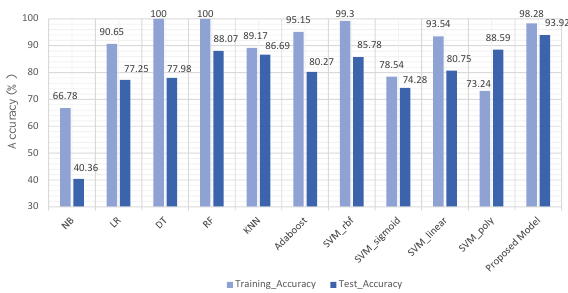
Figure 3. Performance comparison of proposed model with other ML